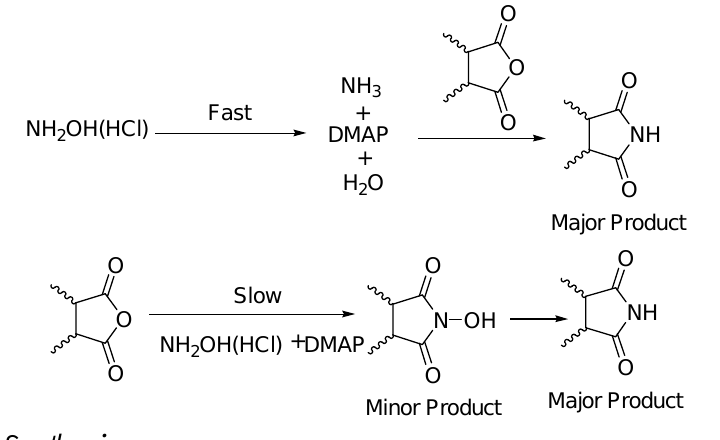
Table 1 . Monomode Synthesis of Unsubstituted Cyclic Imides using NH